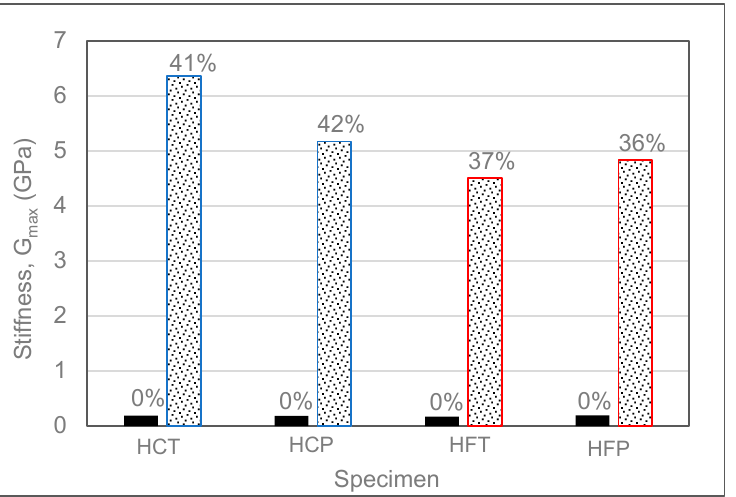
Figure 10. Measured stiffness of sand specimens before hydrate formation, compared to the final stiffness measured 24 h after the onset of hydrate formation for the two different particle size distributions and two different formation paths utilized. The percentages above the bars represent hydrate saturation.